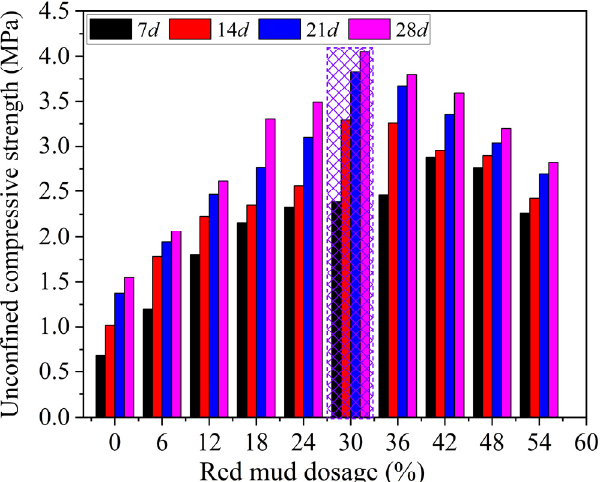
Figure 8. UCS of loessial silt stabilized with different red mud dosage at different curing ages. Moreover, UCS of RMLS increases as the curing age increases with each fixed D R .